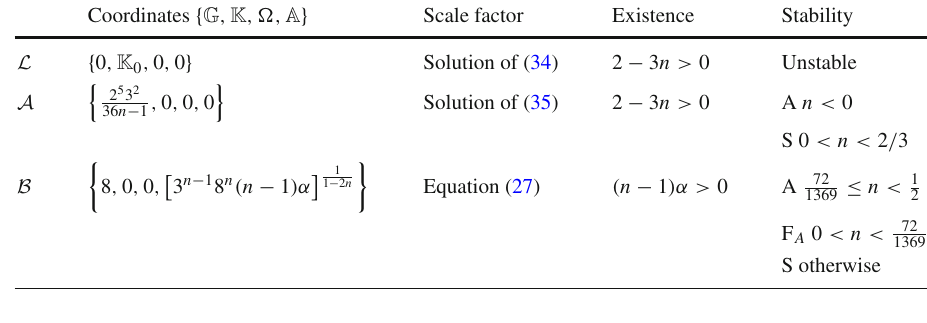
Table 1 Fixed subspaces of f ( G ) = α G n and their associated solutions. Here a 0 = H 1 + H 2 + H 3 , A stays for attractor, F A for attractive focus, S for saddle